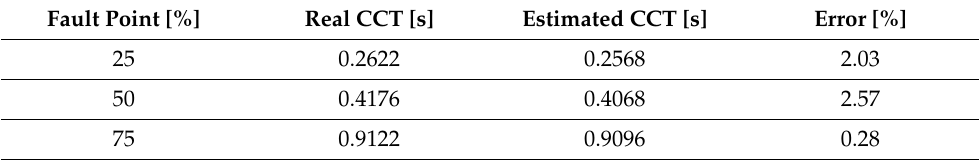
Figure 17. DQN-IMDOB estimations at various fault points. ( a ) ˆ ξ 1 Estimation at λ = 0.25; ( b ) ˆ ξ 1 estimation at λ = 0.5; ( c ) ˆ ξ 1 estimation at λ = 0.75. Table 4. CCT estimations and